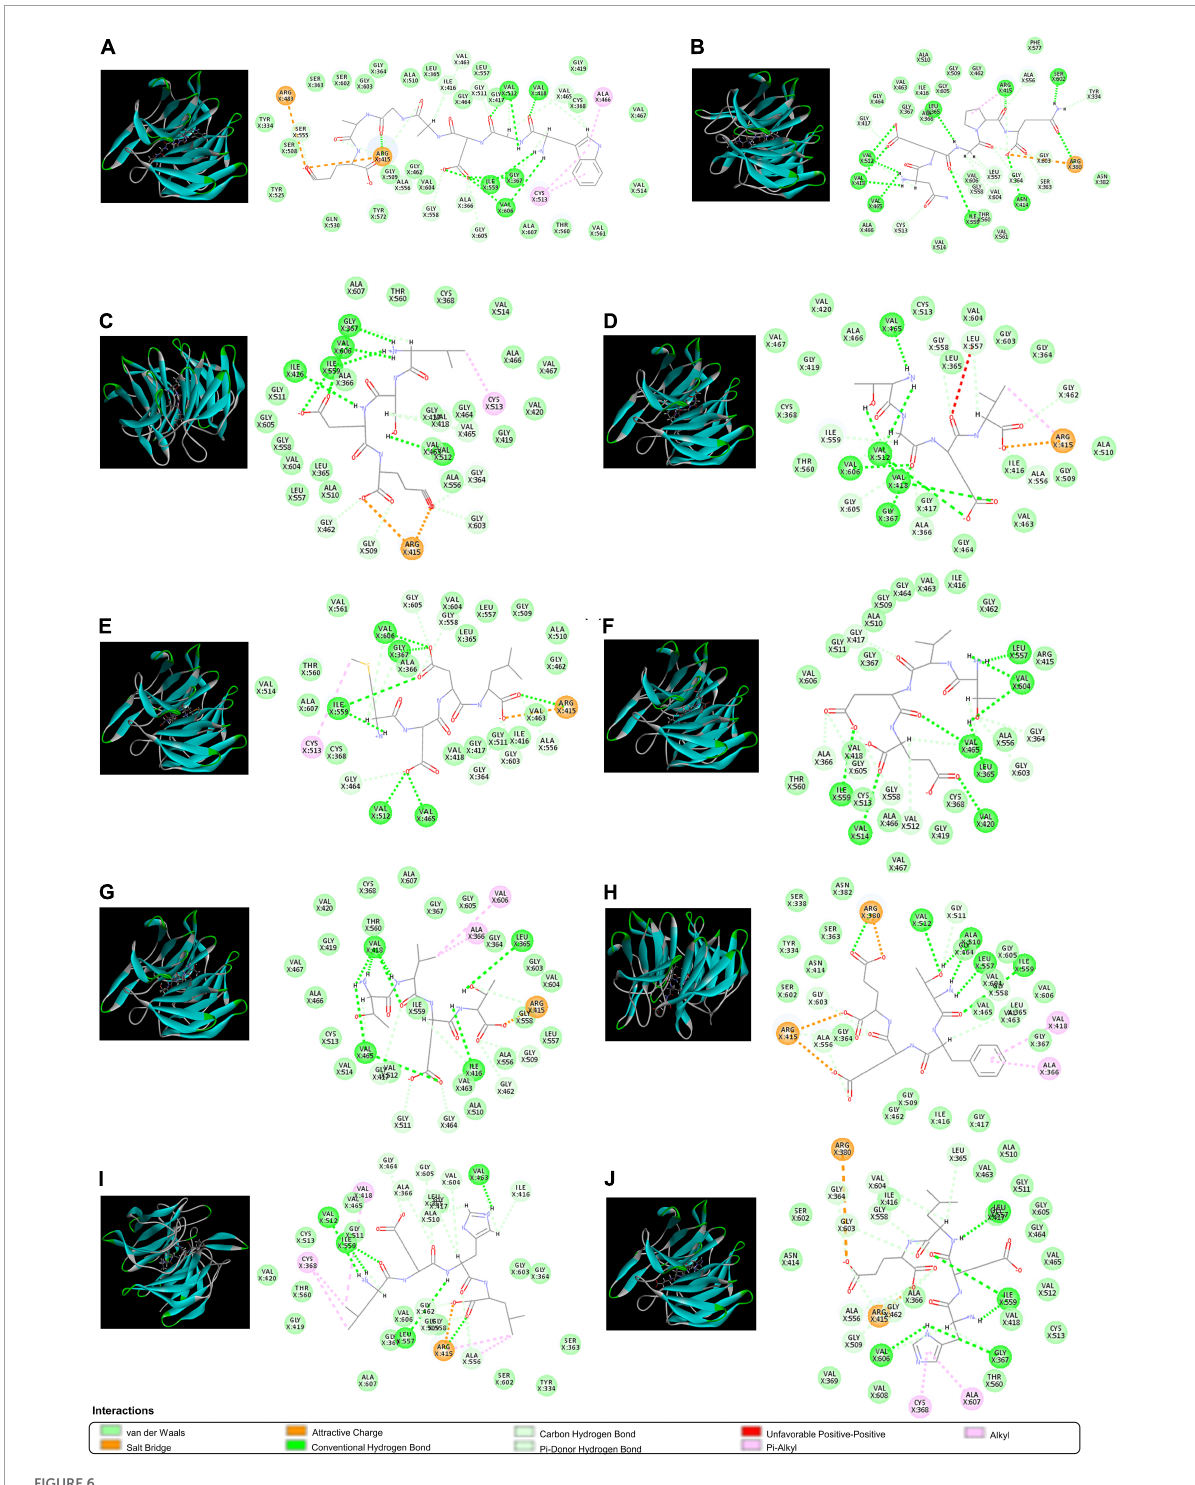
FIGURE6 The 3D and 2D molecular interactions of peptides with the active site of Keap1. (A) #25; (B) #116; (C) #53; (D) #84; (E) #33; (F) #18; (G) #90; (H) #30; (I) #96; and (J) #62.